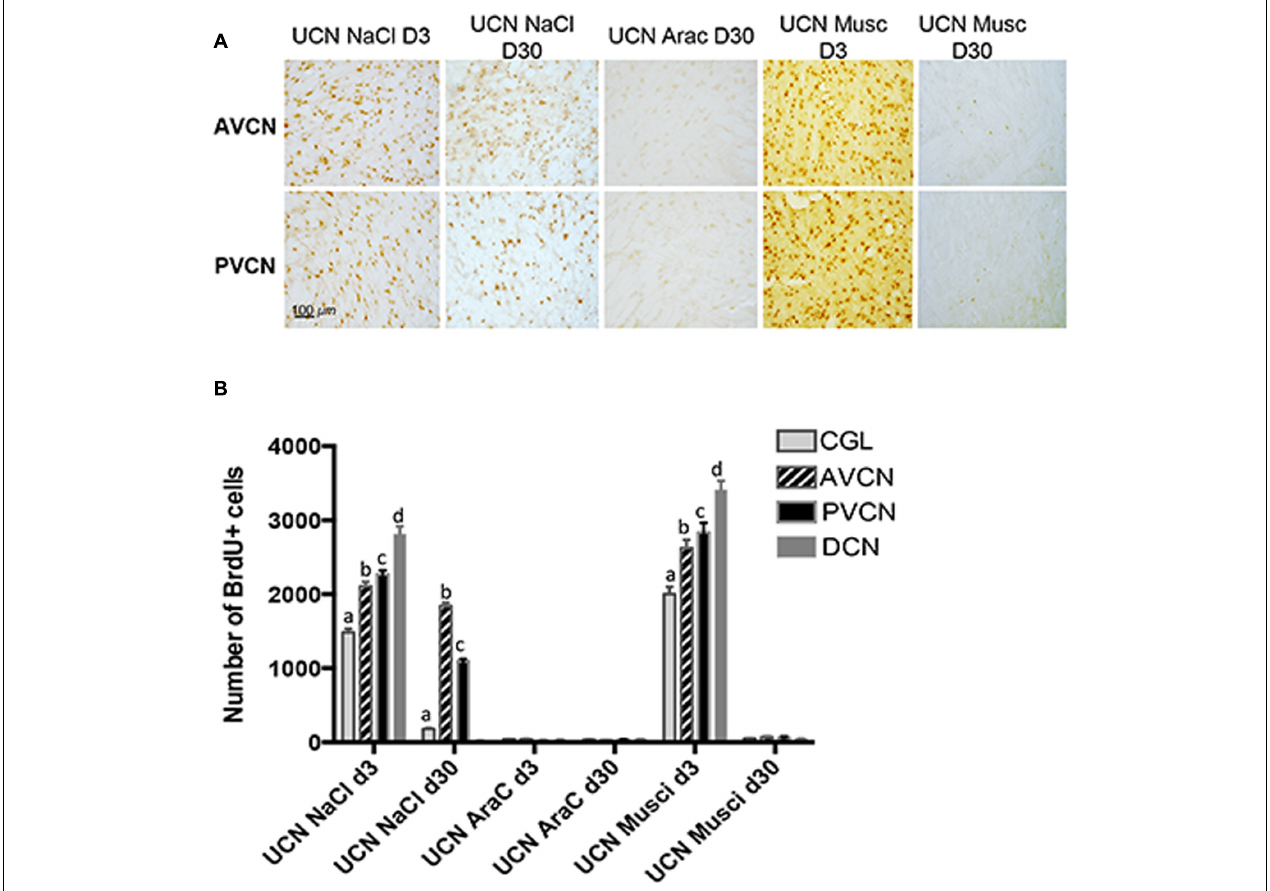
FIGURE 4 | Newborn cells generated 3 days after UCN survived up to 1 month depending on the treatment administrated. (A) Illustrations of BrdU immunoreactivity in both the deafferented AVCN and PVCN at different time points (post-lesion D3 or D30) in UCN animals treated with NaCl-, AraC-, or Muscimol-intra-cerebroventricular infusion. Note that in AraC treated animals, no BrdU + cells were observed at D3 (data not shown) or D30. Scale bar: 100 µ m and n = 4 animals per group. (B) Histograms showing the effects of drug infusion (NaCl, AraC, or Muscimol) on the number of BrdU-immunopositive cells observed in the deafferented cochlear nuclei. Only values recorded on the lesioned side are illustrated. Different letters indicate significant differences between all other groups of animals. Analyzes were assessed by ANOVA followed by the Scheffé test for all VN and groups ( p < 0.0001, see Table 3